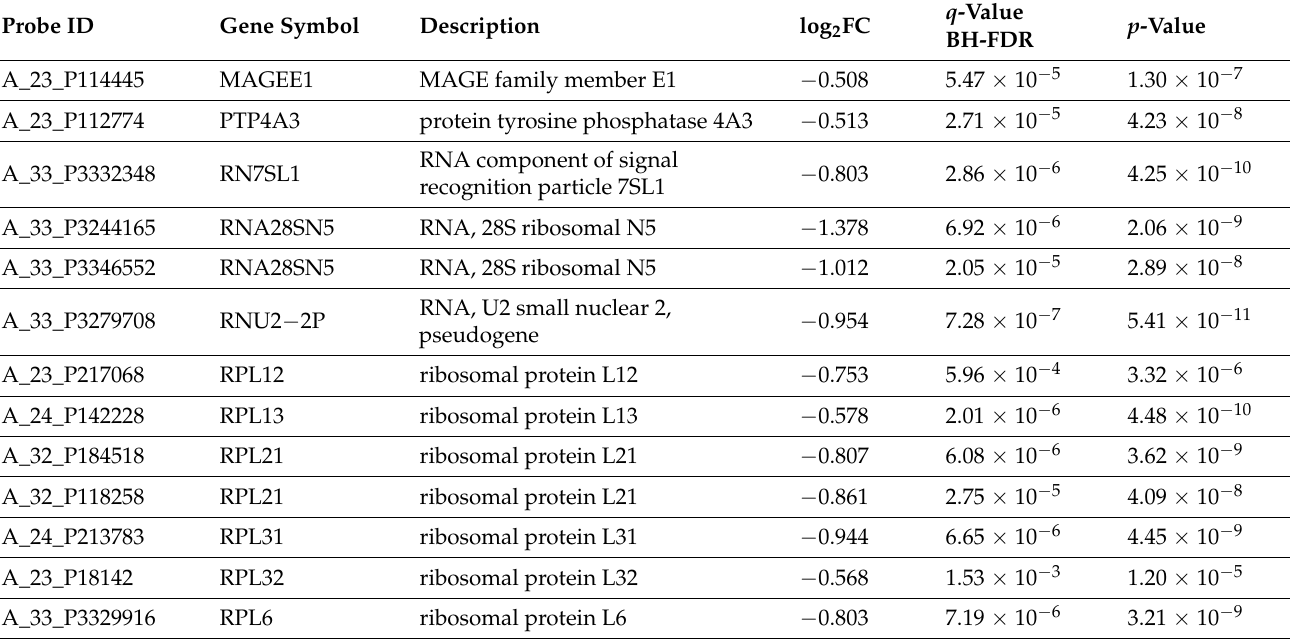
Table 3. Downregulated genes, as resulted from the statistical comparison of melanoma vs. healthy samples (One Class Rank Product). Negative log 2 FC values indicate downregulation in the tumour compared to healthy